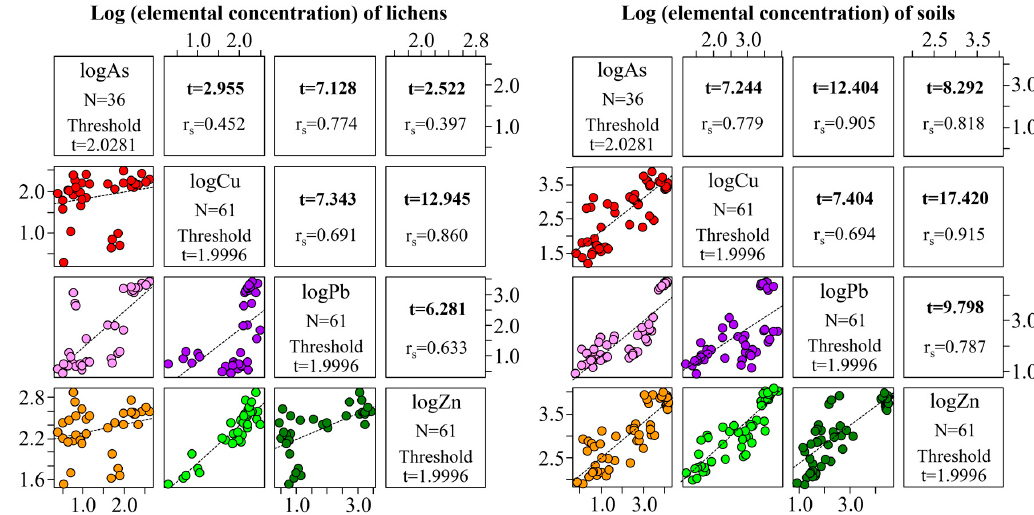
Figure 6. Scatter matrices showing the relationships among each Cu, Zn, As, and Pb concentration in lichens and soils after logarithmic transformation, with regression lines.